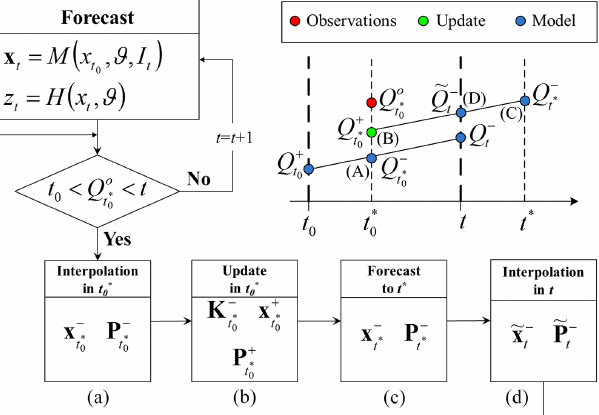
Figure 4. Graphical representation of the data assimilation of the crowdsourced observations (DACO) method used in this study to assimilate asynchronous streamflow crowdsourced